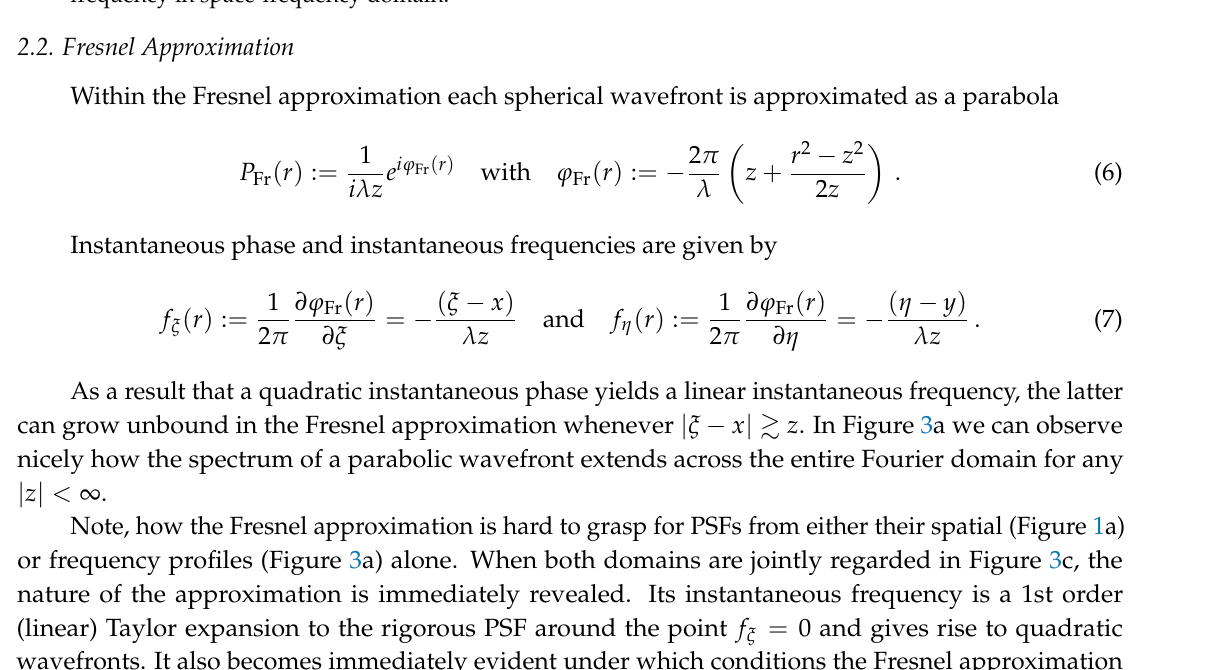
Figure 3. A comparison of the Fresnel approximation with the rigorous form of a single 1D point-spread function in terms of: ( a ) real part in Fourier space; ( b ) instantaneous phase in space; ( c ) instantaneous frequency in space-frequency